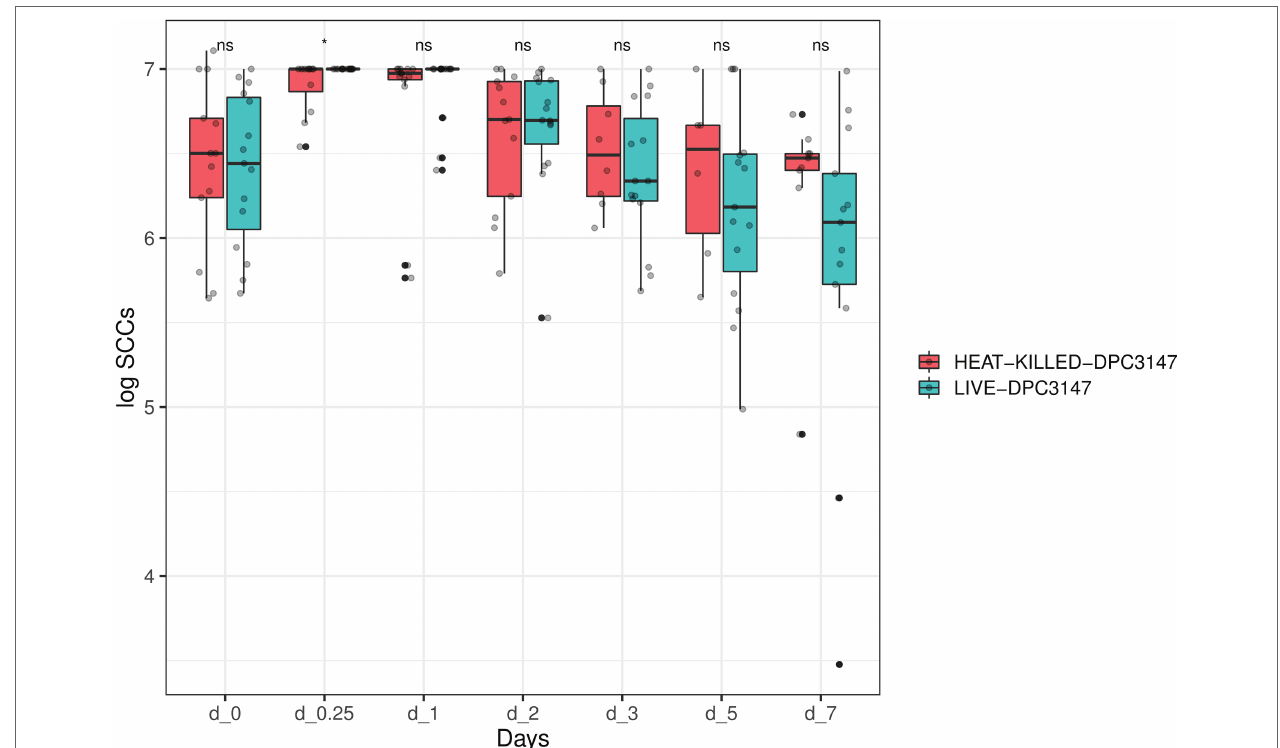
FIGURE 3 | A non-parametric Wilcoxon test was used to compare the SCC values in cows treated with viable DPC3147 cells versus heat-killed DPC3147 cells. There were no statistically significant differences in the SCC values between the two treatment groups at the designated time points ( p > 0.05 in all cases), with